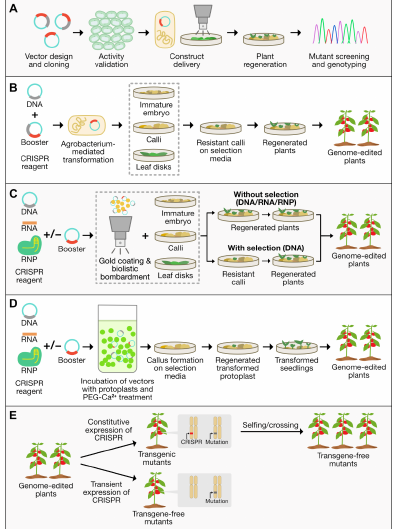
Figure 2. General procedures in plant transformation, delivery methods of CRISPR cargo, and transgene-free mutant development. ( A ) Major steps in plant genome editing. Once transformation vectors are designed and constructed, their activity may be validated with protoplasts before being delivered into the host plant. Protoplast transformation can also be used directly to produce trans- formed cells and eventually plants as described in panel D. The general procedure of transformation also usually followed by a selection process to select resistant cells and seedlings, and finally a se- quencing process to confirm presence of transformed mutants. ( B ) Plant genome editing via Agro- bacterium -mediated delivery of CRISPR DNA. Agrobacterium containing the vectors are transfected into plant cells in the form of calli, embryos, or leaf explants, followed by the selection process to produce genome-edited plants ( C ) Conventional and transient expression approaches for particle bombardment-mediated genome editing via CRISPR DNA, RNA, or RNP delivery. Transformation vectors-coated gold particles are bombarded into plant cells followed by the selection process ( D ) Protoplast transformation with CRISPR DNA, RNA, or RNP. Transformation vectors, protoplasts, PEG, and Ca 2+ ions are mixed before further selection processes to isolate transformed calli, seedlings, and finally genome-edited plants. ( E ) Two ways to obtain transgene-free mutants. Using the conventional method, a selection agent is used to select resistant calli and transgenic plants. Transformation vectors can be segregated out from the mutant genomes via selfing or crossing. Using the transient method, no selection agent is needed to segregate out the transformation vectors to produce transgene-free mutants. [RNP, ribonucleotide